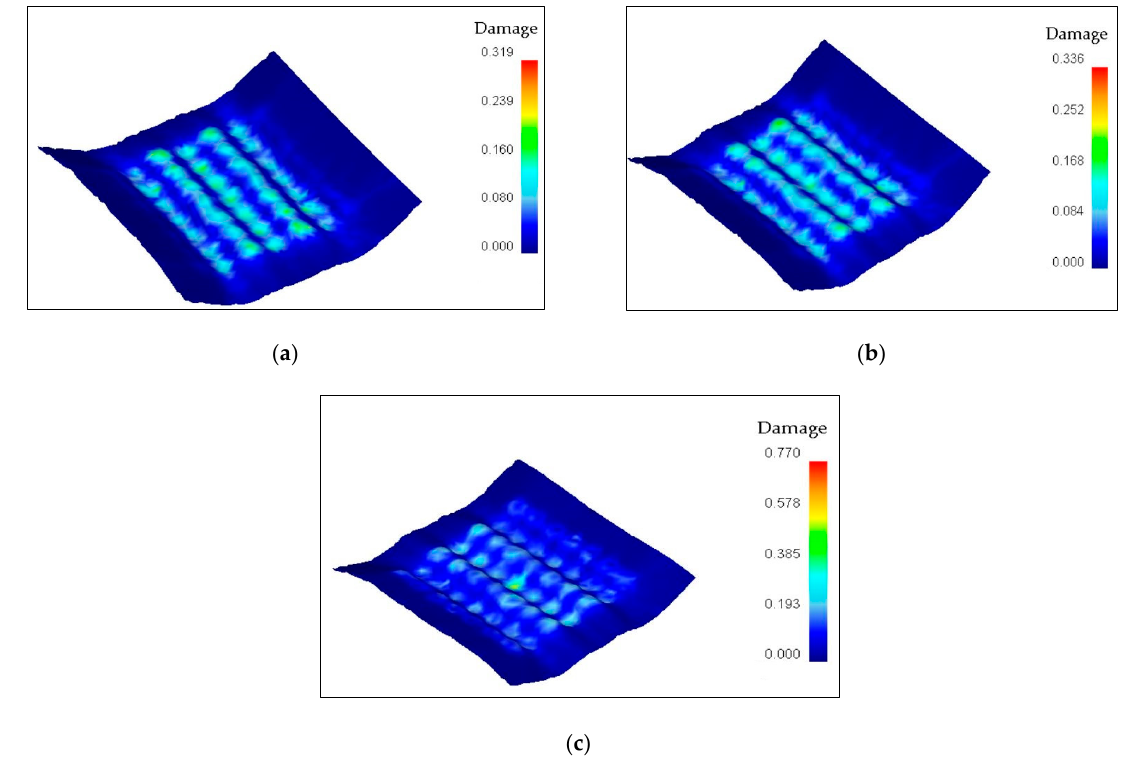
Figure 12. Damage factors of form2 with ( a ) 10 mm pins; ( b ) 12 mm pins; ( c ) 14 mm pins.